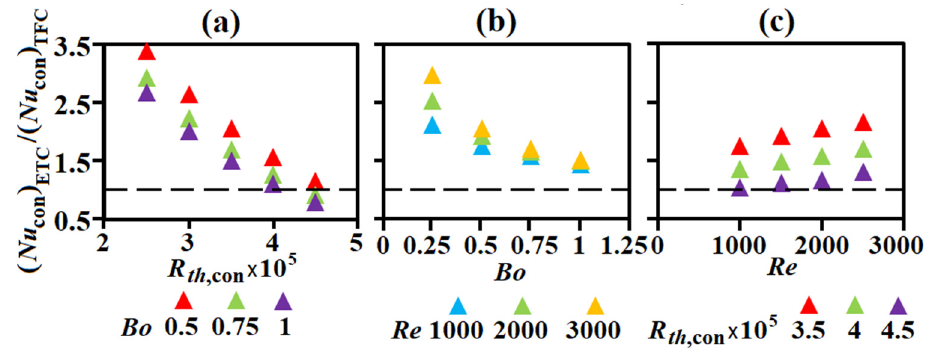
Figure 7. The ratio of Nu con between the loops with ETC and TFC against ( a ) Re , ( b ) Bo , ( c ) R th ,con .